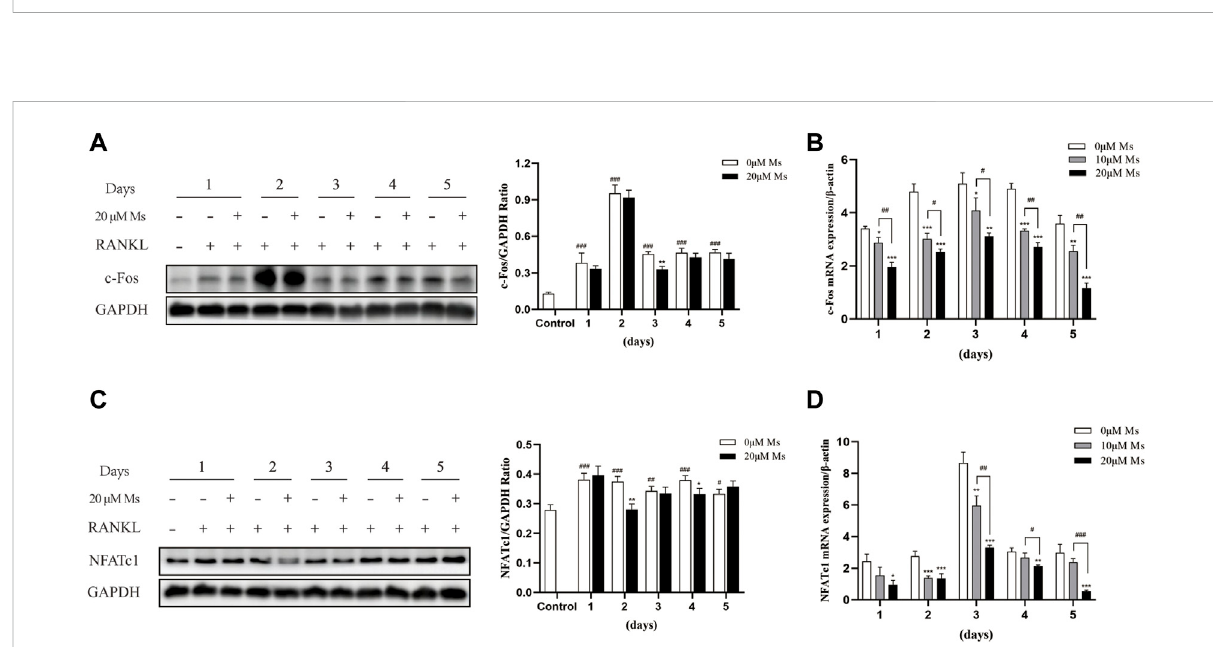
Effect of Ms on NFATc1 and c-Fos expression in RANKL-induced RAW264.7 cells. RAW264.7 cells were treated with varying concentrations of Ms with RANKL (50 ng/ml) for 5 days. The proteins were extracted to analyze c-Fos and NFATc1 expression by Western blot per day (A and C). The mRNA expression levels of c-Fos and NFATc1 genes were analyzed using RT-qPCR per day (B and D). Each point represents the mean ± SD. The experiments were repeated three times. # p < 0.05, ## p < 0.01 and ### p < 0.001 vs. Control group (RANKL-, Ms-); * p < 0.05, ** p < 0.01 vs. *** p < 0.001 vs. corresponding time 0 μ M Ms group (RANKL+,